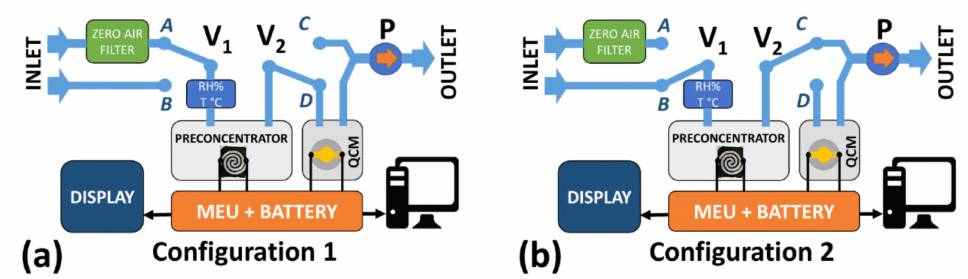
Figure 1. Schematic representation of the measurement system. Configurations C1 ( a ) and configura- tion C2 ( b ).